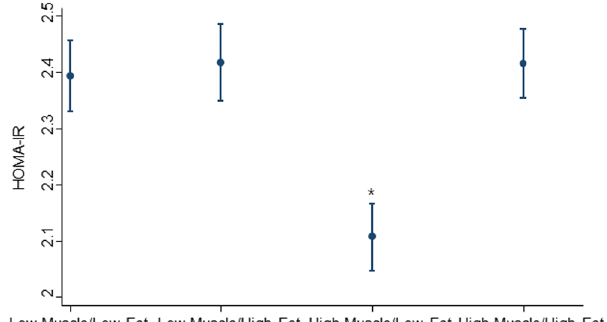
Figure 1. Least square mean of insulin resistance (HOMA-IR) by muscle mass and fat mass. Adjusted for sociodemographic factors (age, sex, education, employment status, area of residence, household income), health behavior (smoking, alcohol consumption, sleep duration, physical activity) and health-related status (BMI, and presence of comorbidity). Abbreviations: BMI, Body Mass Index; HOMA-IR, the Homeostasis Model Assessment of Insulin Resistance * P < 0.001 (reference group is low muscle/low